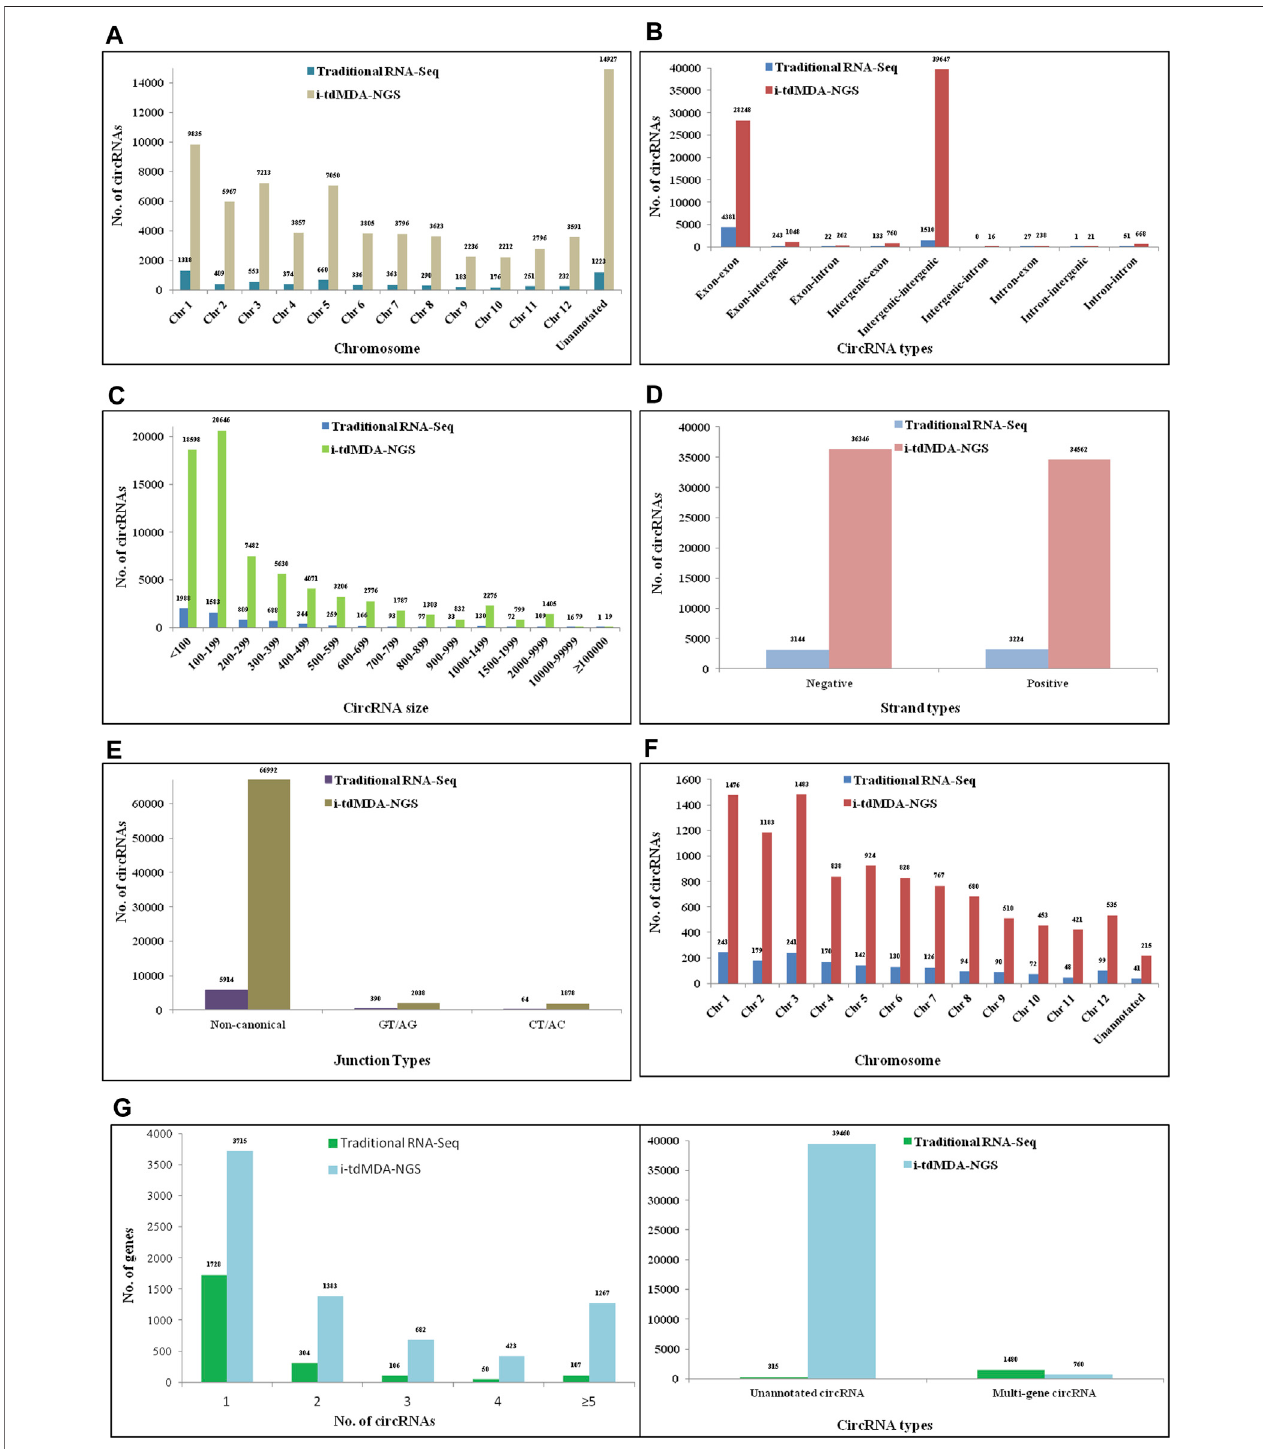
FIGURE 4 | Comparative analysis of HeLa circRNAs by DCC. HeLa circRNAs identi fi ed by traditional circRNA-Seq and i-tdMDA-NGS were analyzed by the DCC computational pipeline and compared based on its (A) location on the chromosome, (B) types, (C) size, (D) strand location, and (E) junction types; (F) expression of circRNAs over the corresponding linear RNA across chromosomes and (G) number of circRNAs per host gene.